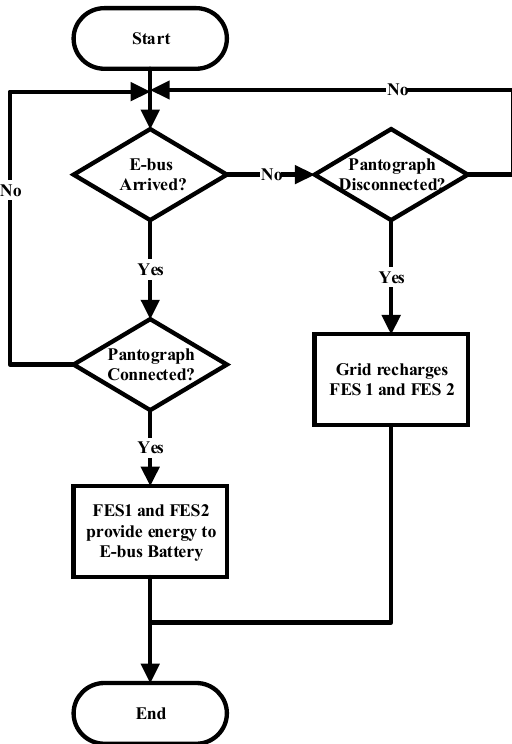
Figure 9. Proposed station charging strategy flowchart.